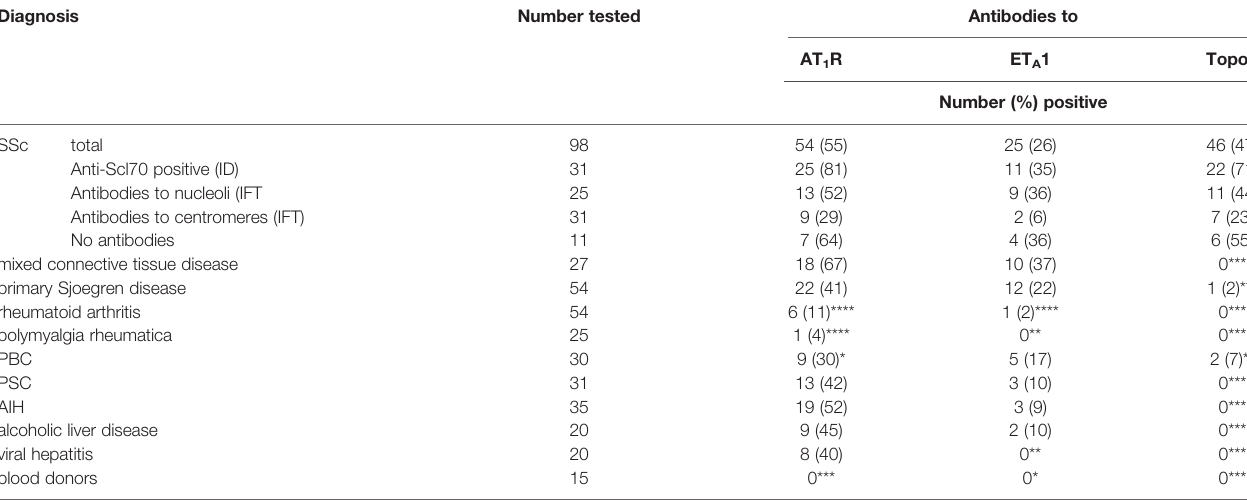
TABLE 2 | Prevalence of antibodies to topo-I, AT 1 R, ET A 1 measured by ELISA in sera from patients with different disorders. Diagnosis Number tested Antibodies